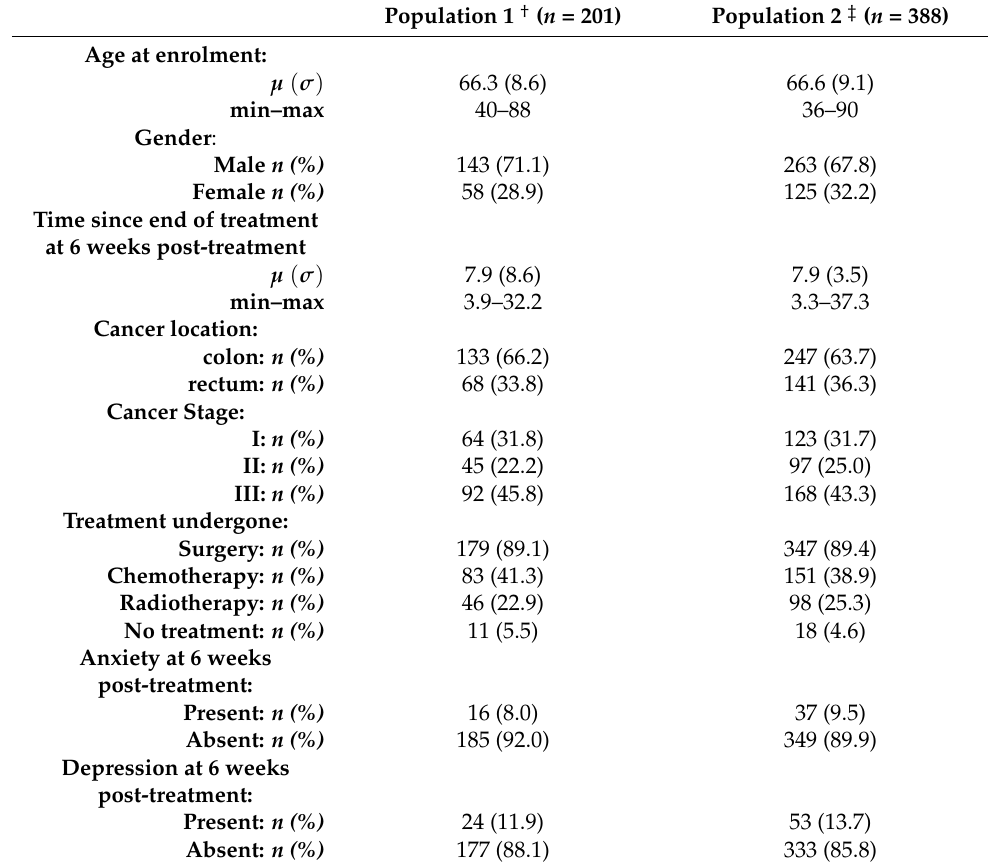
Table A1. Demographic and clinical characteristics of two overlapping participant groups.